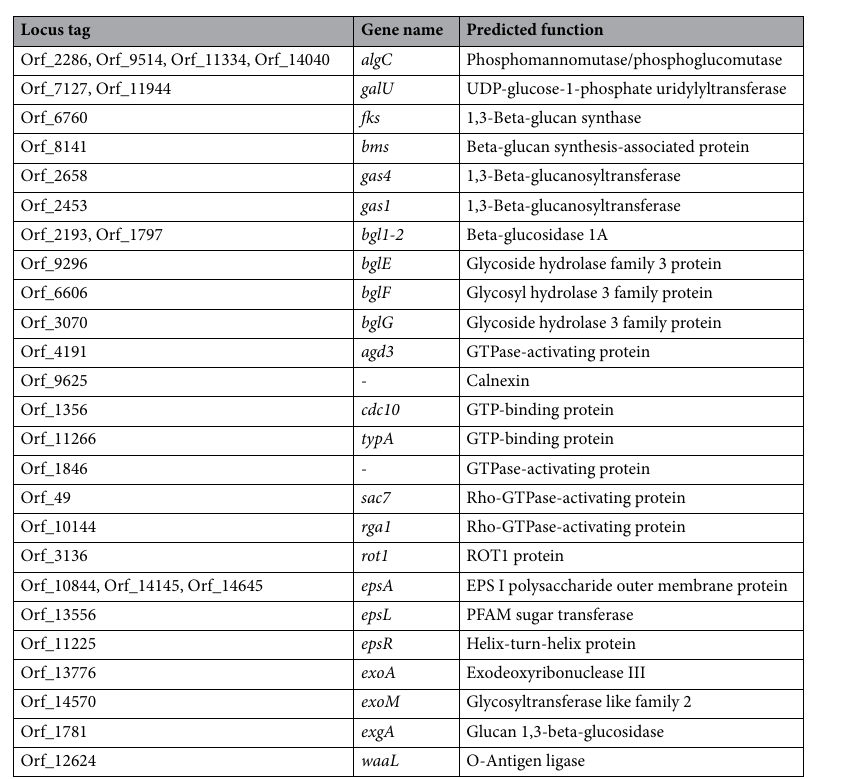
Table 3. Genes involved in exopolysaccharide biosynthesis.